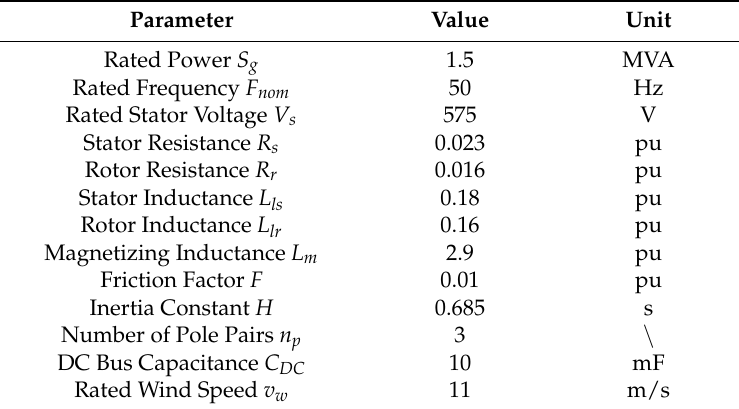
Table 6. Parameters of DFIG-WT.